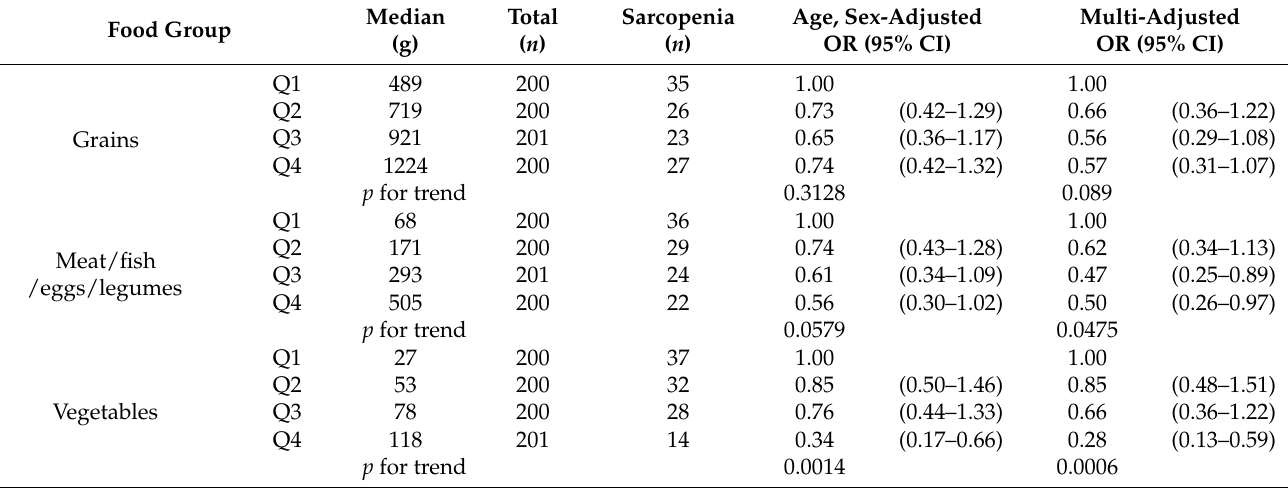
Table 5. Odds ratios (OR) and 95% confidence intervals (CI) of sarcopenia by quartiles (Q) of food group intake and total food